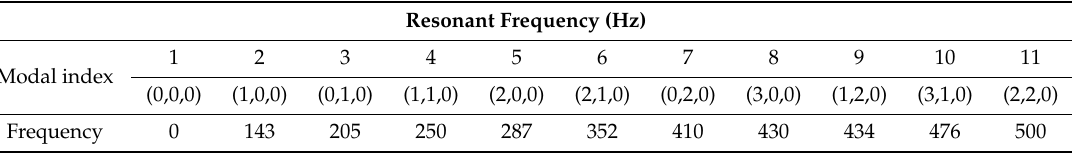
Table 4. The resonant frequencies of the cavity below 500